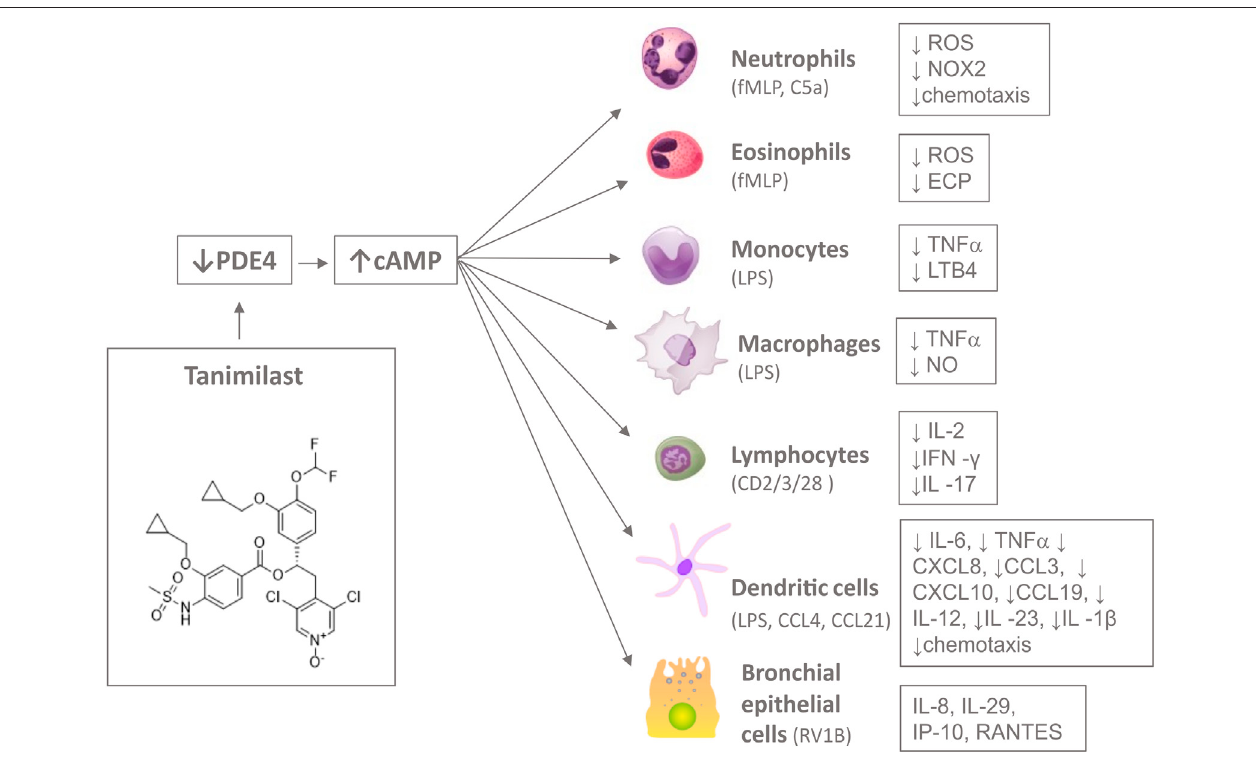
FIGURE1| Inhibition oftheenzymaticactivity ofPDE4bytanimilast induces ariseofthesecond intracellular messengercAMP.Thisresults inadecreasedrelease of a wide range of in fl ammatory mediators and chemotaxis in several cells type of the immune system, including neutrophils, eosinophils, monocytes, macrophages, lymphocytes, dendritic cells and bronchial epithelial cells upon various stimuli (in brackets). Figure objects were adapted by OpenStax College and Database Center for LifeScience(DBCLS)CCBY3.0https://creativecommons.org/licenses/by/3.0and!Original:ArcadianVector:XcepticZP,Publicdomain,viaWikimediaCommons.